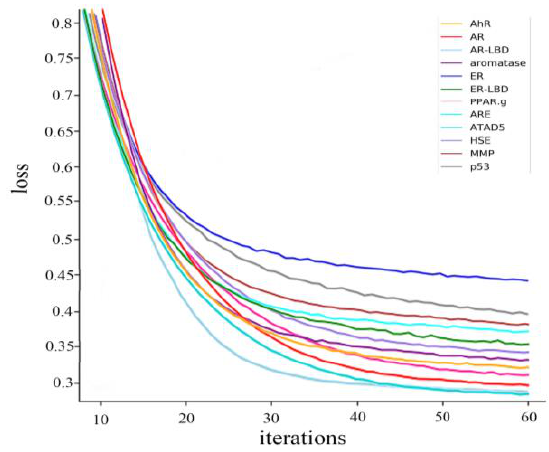
Figure 7. Training loss curve.